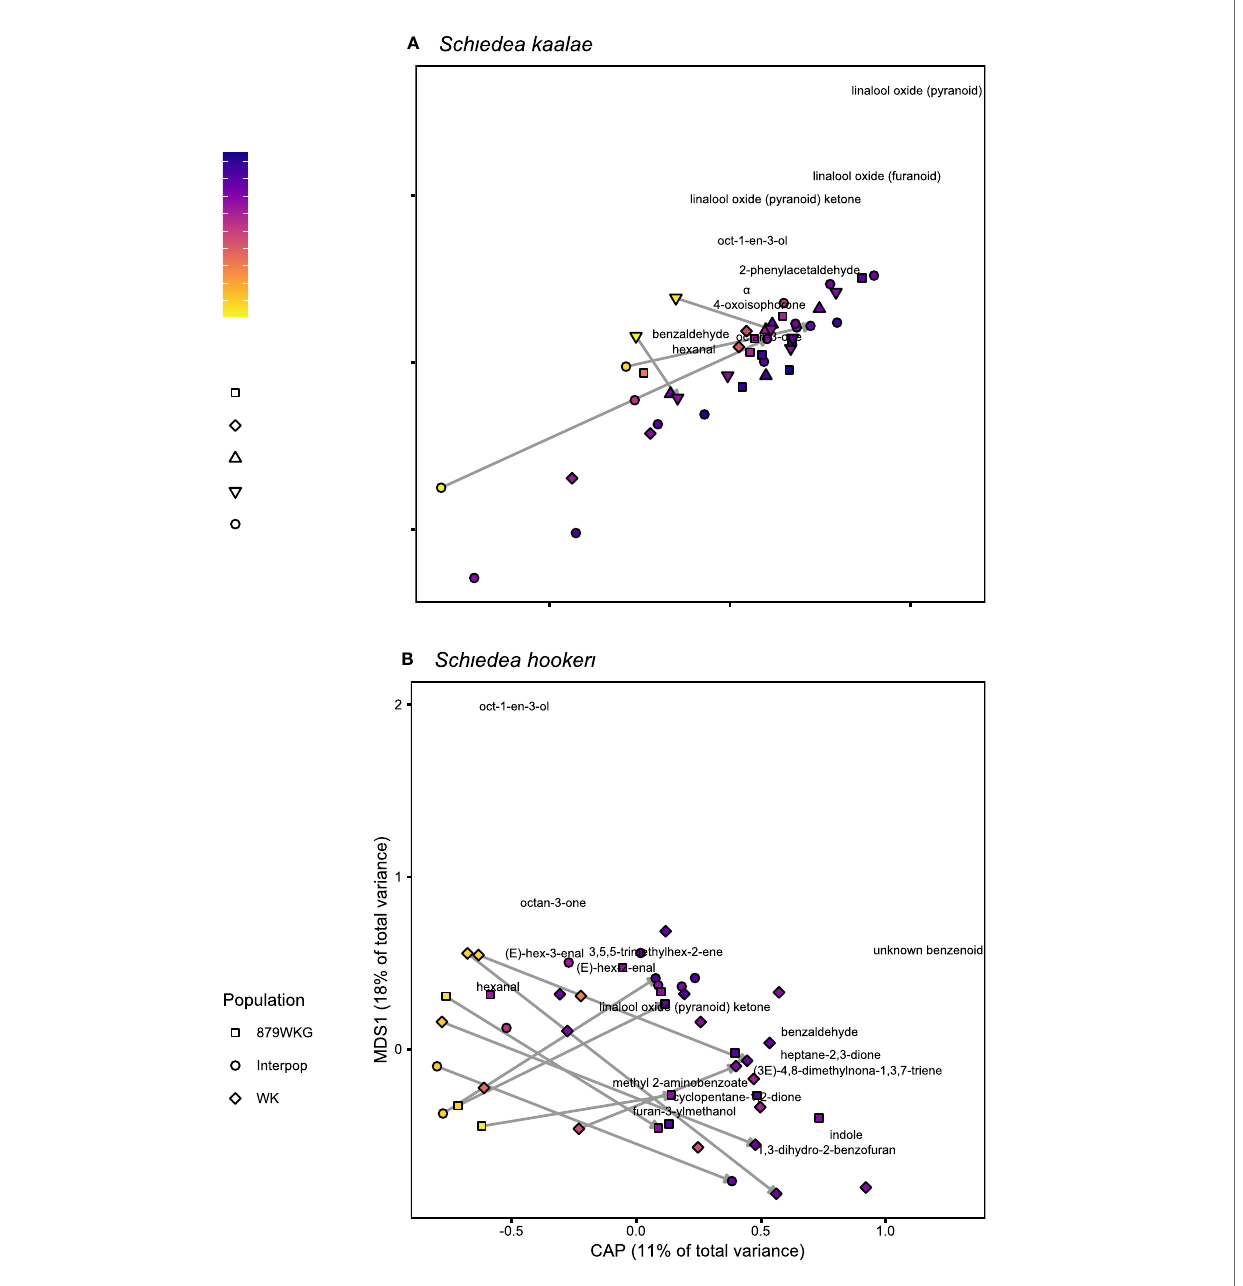
FIGURE 1 | Floral scent composition determined by GC-MS of (A) Schiedea kaalae and (B) S. hookeri plants sampled at different times of day, visualized by canonical analyses of principal coordinates (CAP). The CAP axis shows scent variation explained by time of day (evening on the right), and the fi rst multidimensional scaling (MDS) axis shows additional unconstrained scent variation. The shape of the points indicates the source population number (collection locations in Supplementary Table S1 ) or a plant from a cross between populations ( “ Interpop ” ). Color indicates the time of collection, with zero indicating sunset, positive values indicating time after sunset, and negative values indicating time before sunset. Arrows connect samples of the same in fl orescence during the day and following night. The names of volatiles are positioned by their CAP and MDS scores and labelled if they are > 0.05 units from the